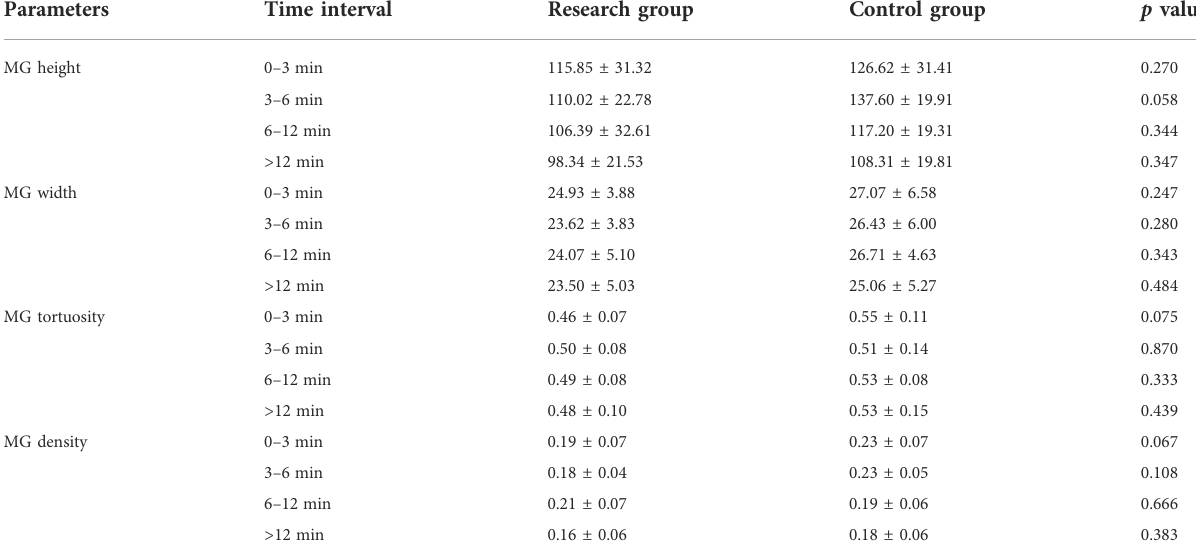
TABLE 4 The changes in MG morphology parameters over time.